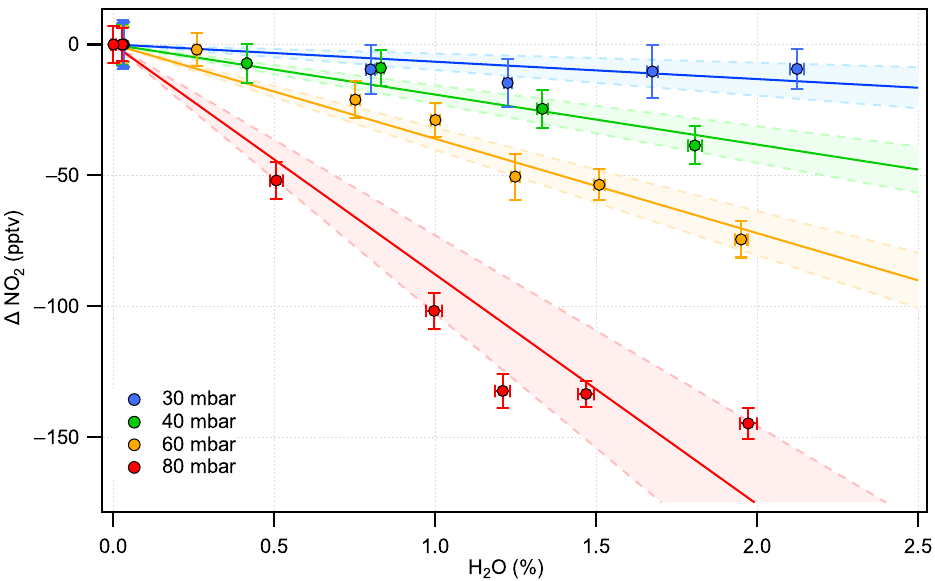
Figure 6. Influence of water vapor on the retrieved NO 2 amount fraction. The negative bias ( ∆ NO 2 , corresponding to the difference between wet and dry conditions) is plotted as a function of the absolute humidity of the sample at different pressures. The confidence intervals ( ˘ 95%) of the linear regressions are indicated by shaded areas. The error bars indicate the 1 σ standard deviation of the measured ∆ NO 2 and the uncertainties of the water measurements (k =